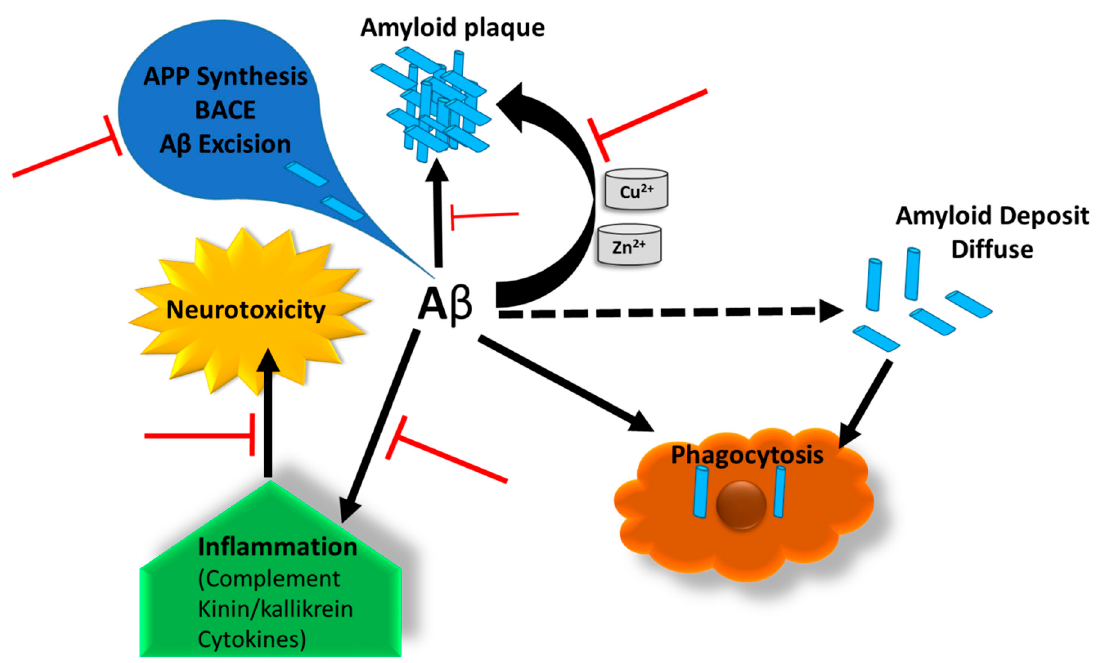
Figure 6. Possible protective actions of heparin in Alzheimer’s disease (AD) pathology. Heparin-based protection can be realized by: (1) reduction of A β generation by an action on amyloid precursor protein (APP); (2) prevention of A β aggregation/deposition in senile plaques; (3) reduction of the inflammatory response (complement, kinin system); (4) binding to homotetrameric Cu 2+ and Zn 2+ containing glycoprotein, and regulating the activity of these metals which reduce accumulation of A β peptides. (Red line indicates the actions of heparin on A β ).